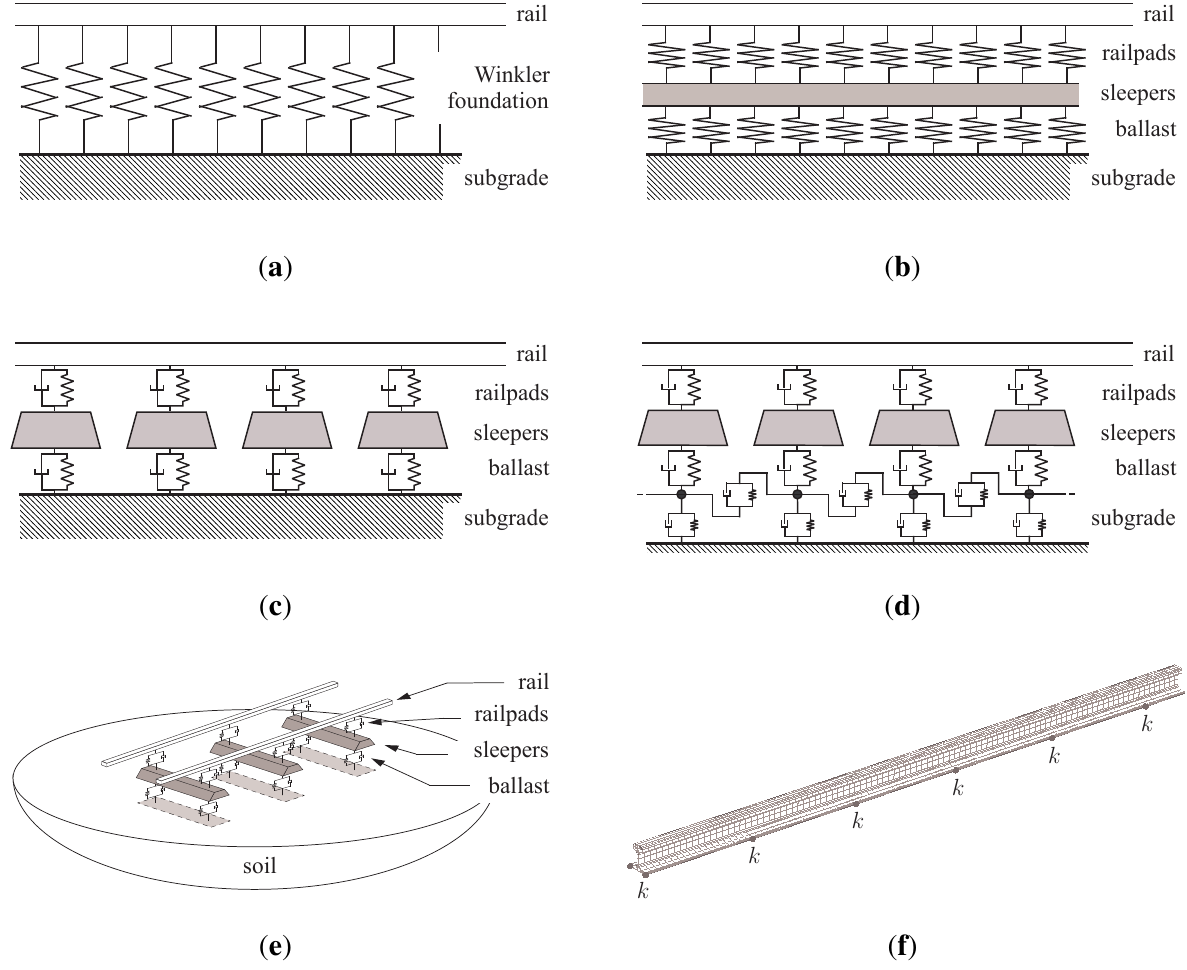
Figure 8. Track modelling: a review. ( a ) 2D single layer track model (continuously supported); ( b ) 2D two layer track model (continuously supported); ( c ) 2D two layer track model (discretely supported); ( d ) 2D three layer track model (discretely supported); ( e ) 3D three layer track/soil model (discretely supported); ( f ) 3D model for the rail (discretely